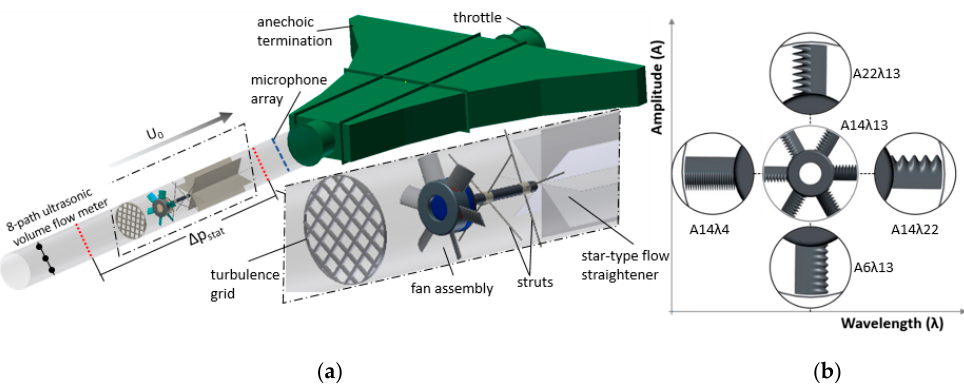
Figure 3. ( a ) Aeroacoustic test rig according to ISO 5136 [23]; ( b ) Analyzed serration designs for the tested rotors. Absolute values for amplitude A and wavelength λ are indicated in mm. Rotor blade span S = 0.098 m, rotor blade chord C = 0.075 m, duct radius R Duct = 0.2 m.